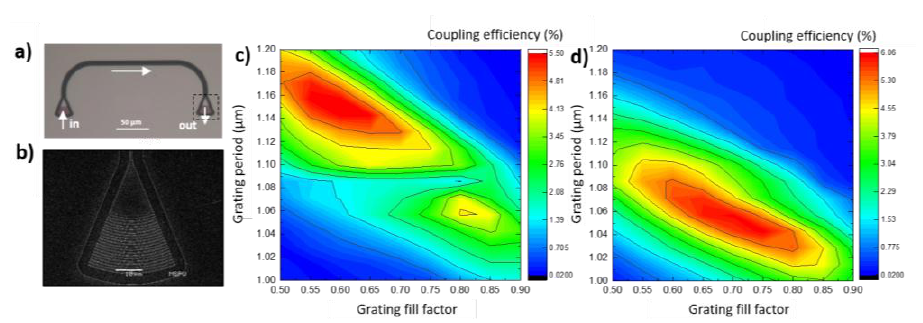
Fig. 1. (a) Image of a fabricated nanophotonic circuit with a waveguide and two FGCs. (b) Image of the FGC obtained by scanning electron microscope. The measured FGC efficiency versus different periods and filling factors: before (c) and after (d) deposition of SiO